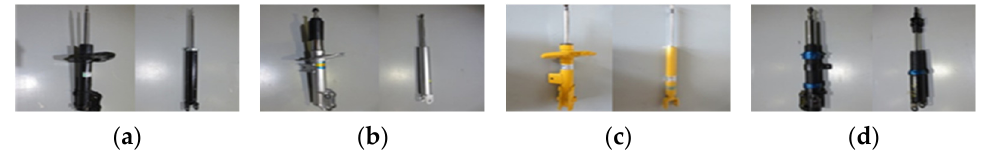
Table 2. Suspension component classification. Figure 4. Target damper parts(front/rear): ( a ) Reference Damper, ( b ) Damper A, ( c ) Damper B, and ( d ) Damper C.